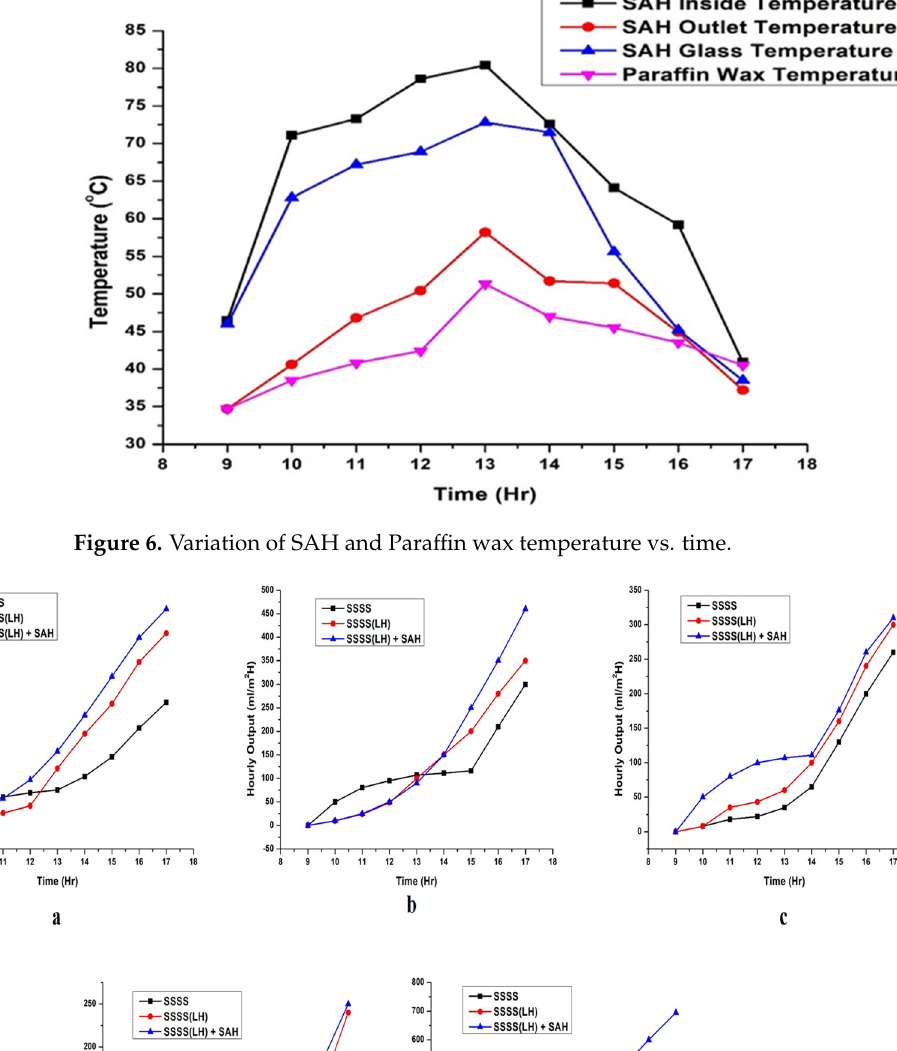
Figure 5. ( a – e ) Variation of glass temperature vs. time at the depth of 3 cm, 6 cm, 9 cm, 12 cm, and 15 cm, respectively.